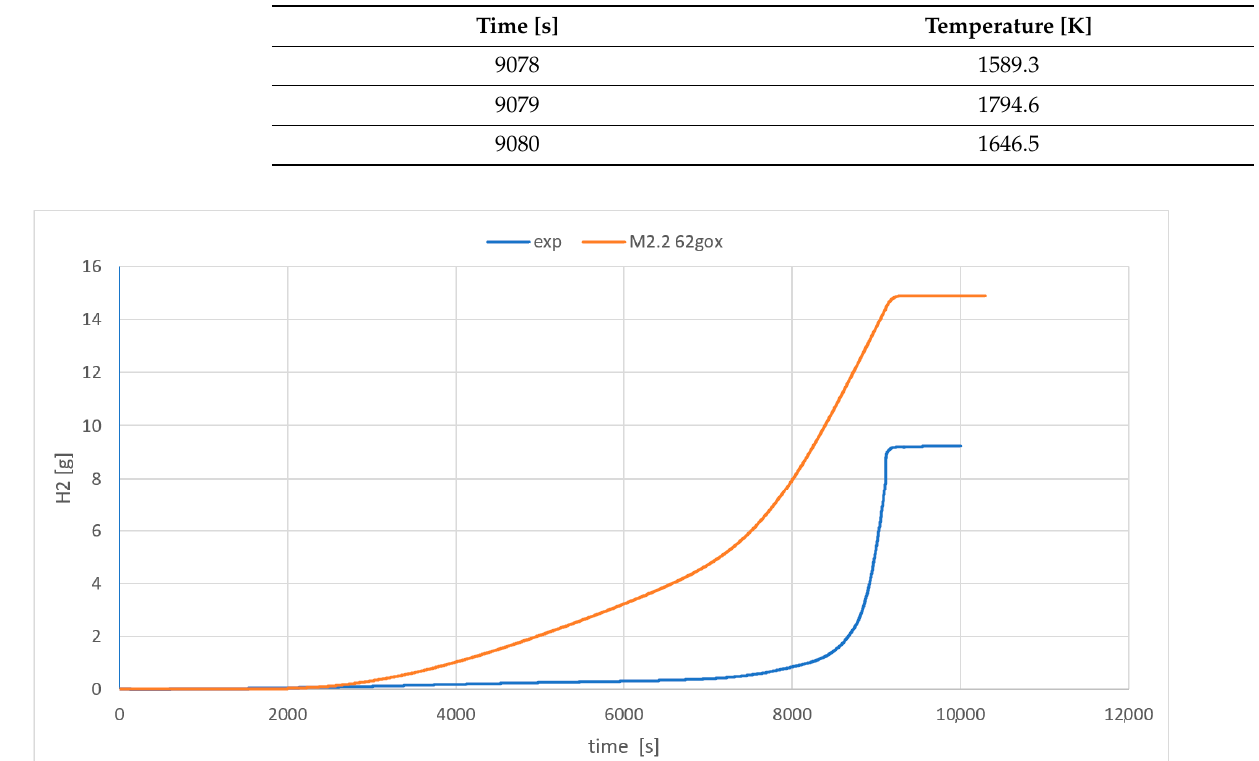
Table 4. Cut-out of the measured temperature table for the axial position 950 mm of the heated rod n. 17 [12].